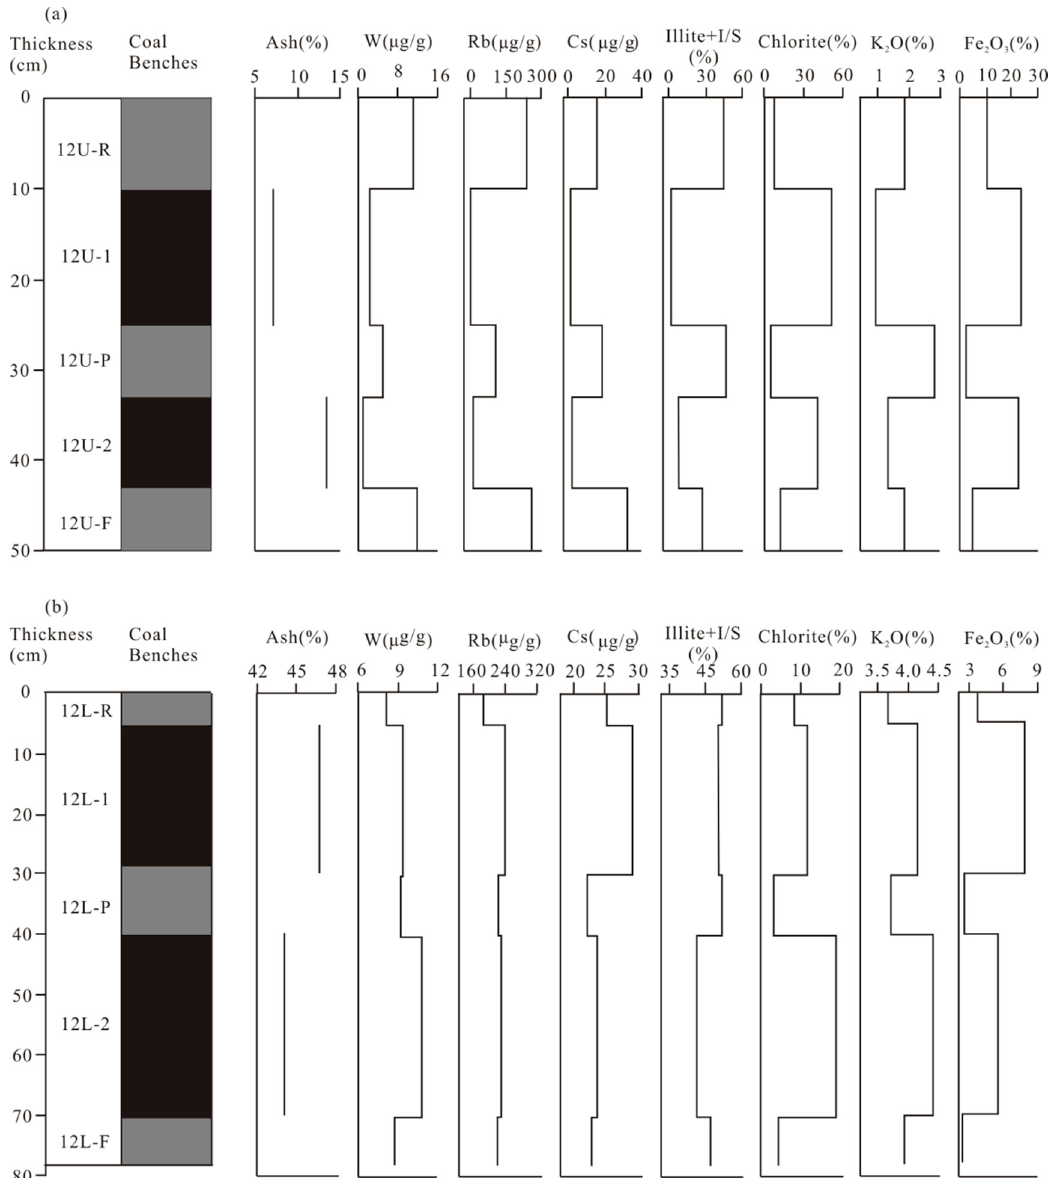
Figure 11. Vertical variations of W, Rb, Cs, illite + I/S, chlorite, K 2 O, and Fe 2 O 3 concentrations, as well as ash yield contents in the coal. ( a ) 12U Coal; ( b ) 12L Coal.